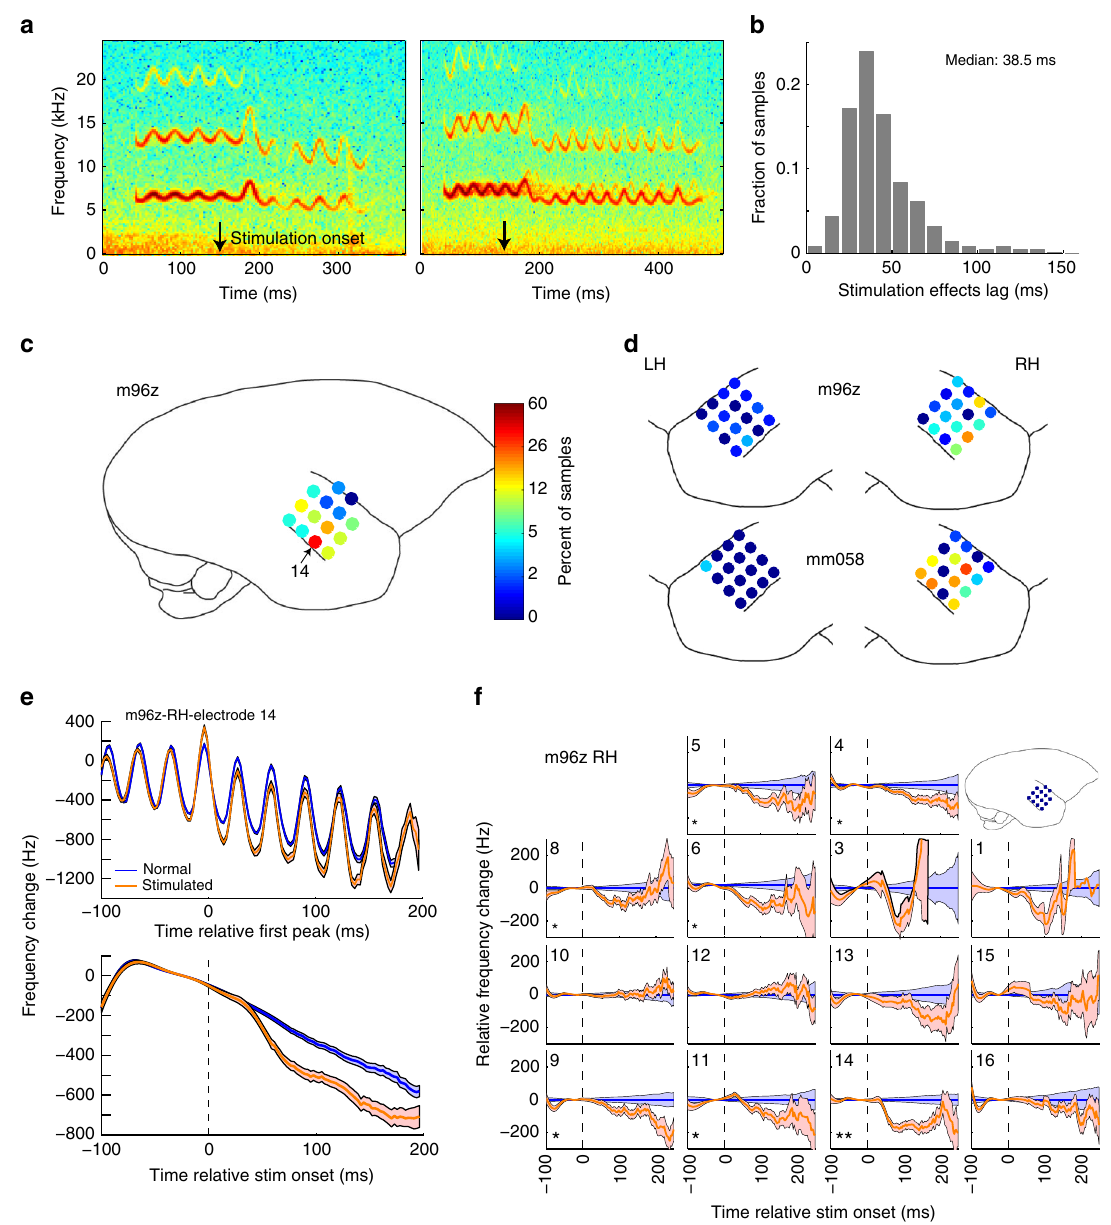
Fig. 7 Vocal frequency changes during electrical microstimulation of auditory cortex. a Two sample trill spectrograms showing abrupt changes in vocal frequencies shortly following stimulation onset (arrows). b Distribution of timing latency between stimulation onset and vocal changes demonstrating rapid stimulation effects. c Spatial distribution of stimulation effects (percent of trill samples demonstrating frequency changes) in one right hemispheric electrode array. Indicated electrode locations are approximate. d Stimulation distribution for two additional left (LH) and right (RH) hemispheric arrays in two animals. Color scale is identical to c . e Vocal contours for a single stimulation site (indicated in c ) comparing normal and stimulated mean frequency curves aligned either by the fi rst trill peak after stimulation (top), or smoothed curves aligned by stimulation onset (bottom), demonstrating onset peak and rapid reduction (Error bars: SEM). f Vocal frequency contours for a right hemisphere grid (m96z-grid in c ) demonstrating a mix of electrodes with strong stimulation effects and others with weak to absent changes. (* p < 0.05, ** p < 0.001, Wilcoxon (MUA) at different recording sites; MUA re fl ects the summed responses of local (System III) in free- fi eld through a speaker (B&W 686 S2) located ~1 m in front of populations of neurons 35 . We generated MUA by fi rst subtracting the reference the animal. Stimuli included tones (1 – 32kHz, 10/octave; − 10 to 80dB SPL by 10 electrode signal from the raw neural signal, then band-pass fi ltering (300 – 5000 Hz, dB), bandpass noise (1 – 32kHz, 5/octave, 1 octave bandwidth) frequency responses 4-pole butterworth), full-wave rectifying, and fi nally low-pass fi ltering (500Hz, 8- areas (FRA), and wide-band noise stimuli. The center frequency (CF) of a neuron ’ s pole butterworth) before down-sampling. MUA responses were later used in FRA was determined by the pure tone stimulus with the highest fi ring rate selected analyses, mainly for comparison to microstimulaton results. response, or from bandpass when no tone response was present. We also presented multiple recorded vocalizations at different sound levels, including samples of Auditory stimulus presentation . Prior to each session of neural recording in the animals ’ own vocalizations (previously recorded from those animals) and con- speci fi c vocalization samples (from other animals in the marmoset colony). Vocal colony, we fi rst characterized the auditory tuning of neurons by the presentation of stimuli were presented at multiple sound levels, but only those samples overlapping auditory stimuli. Marmosets were seated in a custom primate chair within a produced vocalization loudness were used for comparisons between vocal pro- soundproof chamber (Industrial Acoustics, Bronx NY). Auditory stimuli were duction and auditory playback. digitally generated at 97.6 kHz sampling rate and delivered using TDT hardware